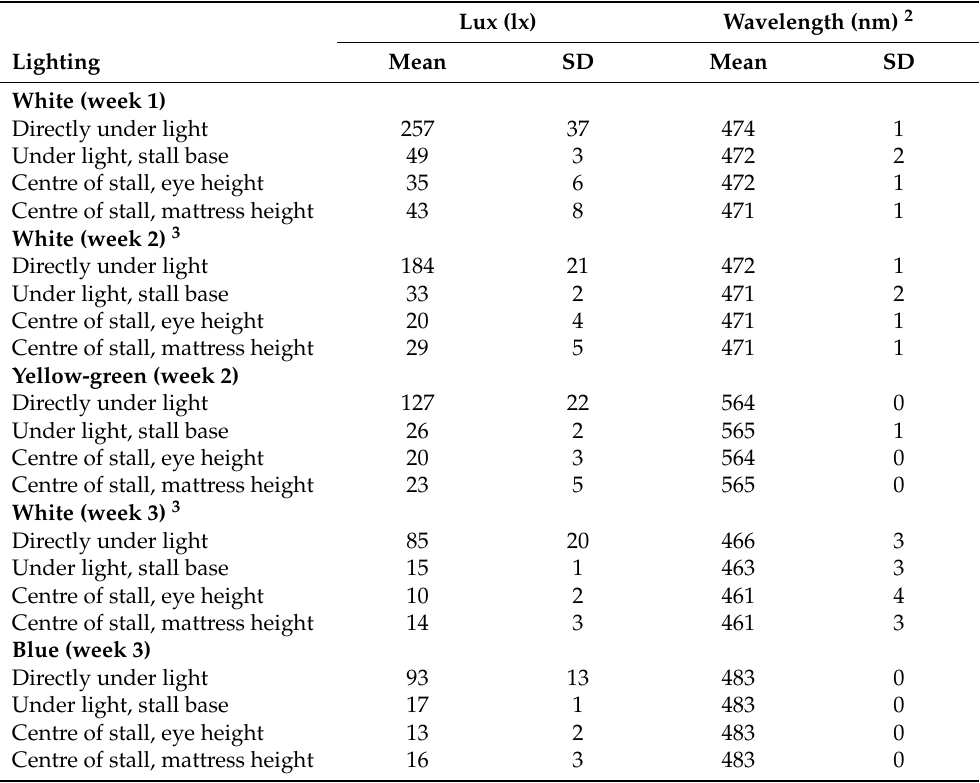
Note 1: all measurements were taken using a spectrometer with the sensor facing the ceiling (i.e., horizontal) to minimise variation resulting from the sensor position. Note 2: daylight conditions were cloudy with minimal sun and measurements were taken between 1000 and 1100 h on one day. 1 Wavelength measurements at the divider were not included. Stalls at the end of each platform were measured in the stall centre only since lights were not installed in the end partitions. 2 Wavelength reported is the most prominent wavelength in each measurement and does not reflect the distributions of wavelengths. Table A2. Descriptive statistics of LED light illuminance (lux) and wavelength measured when the facility was dark (no external light). Measurements were taken in four places 1 per stall in all stalls ( n = 28).